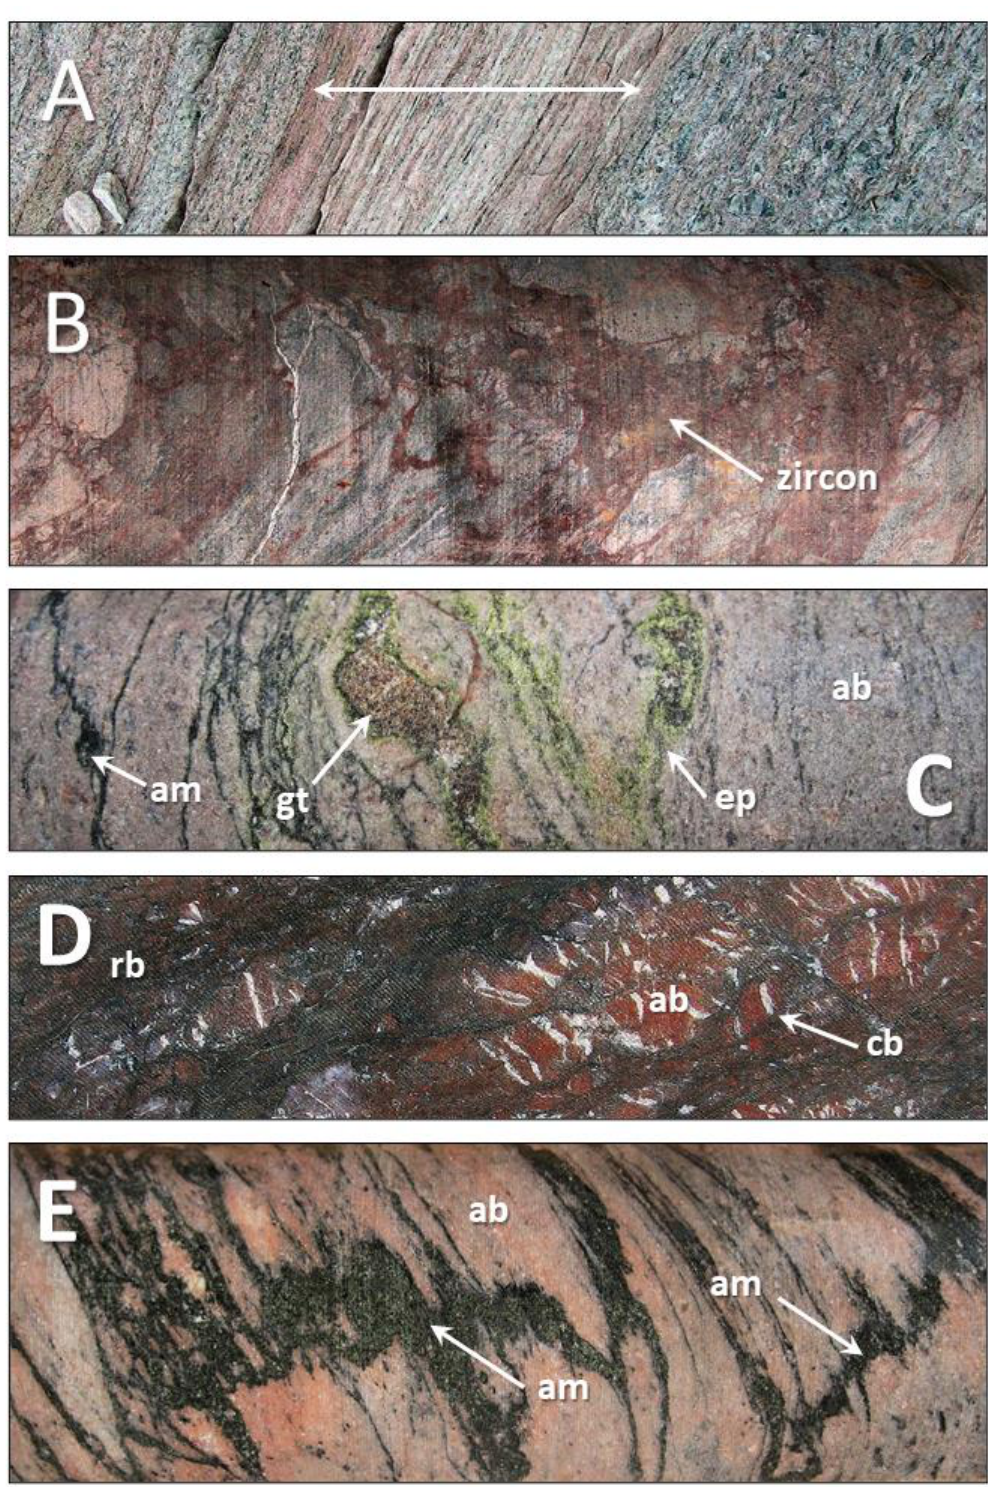
Figure 6. Photographs of core samples, field of view approximately 10 cm. ( A )—shear zone in felsic meta-volcanic rock, Michelin deposit, Central Mineral Belt. ( B )—hydrothermal zircon cemented breccia, Valhalla, Mt Isa District. ( C )—hydrothermal garnet (gt) and late epidote (ep) cutting albitite (ab), Michelin deposit. ( D )—early albitite (ab) clasts in shear zone defined by lineated riebeckite (rb) and late carbonate veins (cb), Queen’s Gift deposit, Mt Isa District. ( E )—amphibole (am) veins cutting albitite (ab), Michelin deposit.